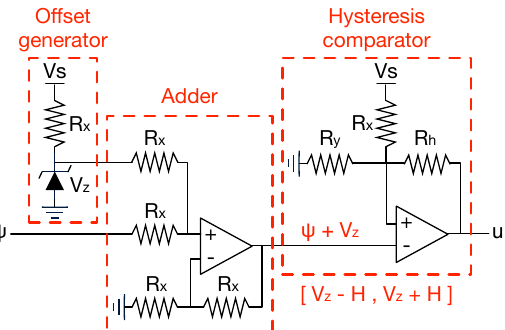
Figure 9. Switching circuit implementing the control law